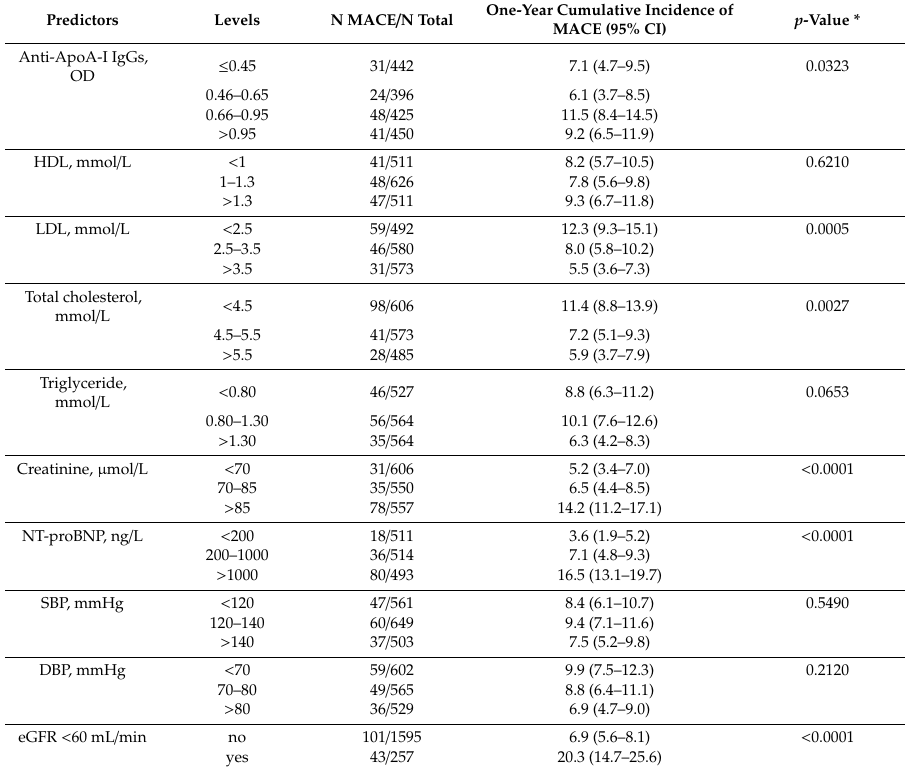
Table 3. One-year cumulative major adverse cardiovascular events (MACE) incidence according to univariate analyses.